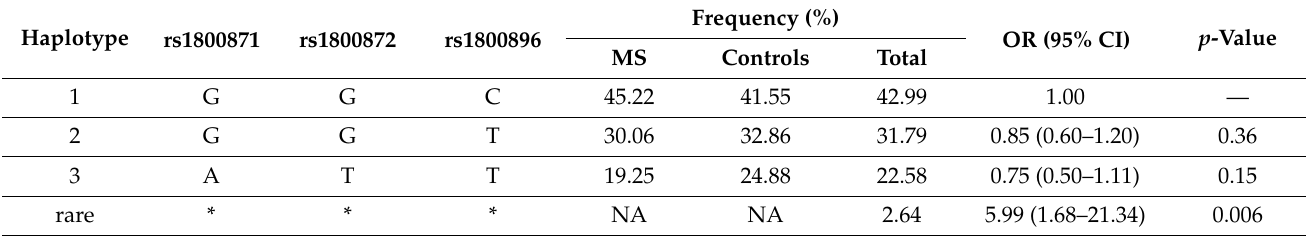
Table 7. Associations between IL-10 haplotypes and risk of multiple